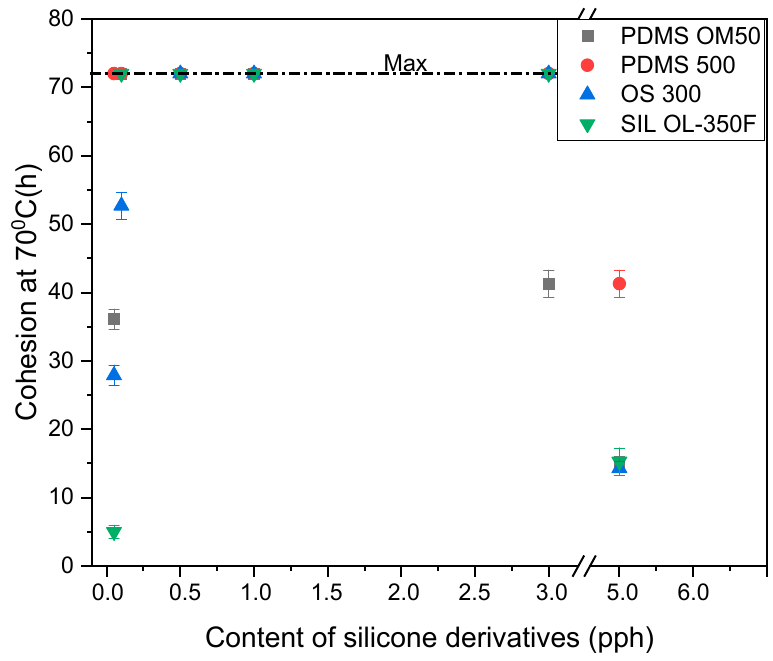
Figure 3. The cohesion at 70 °C of modified silicone pressure sensitive adhesives.